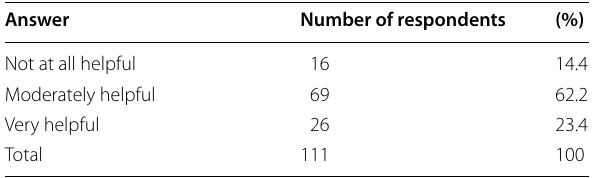
Table 12 Experience of 111 respondents with AI-based algorithms for clinical workflow prioritisation: Has the algorithm proven to be helpful in reducing the workload for the medical